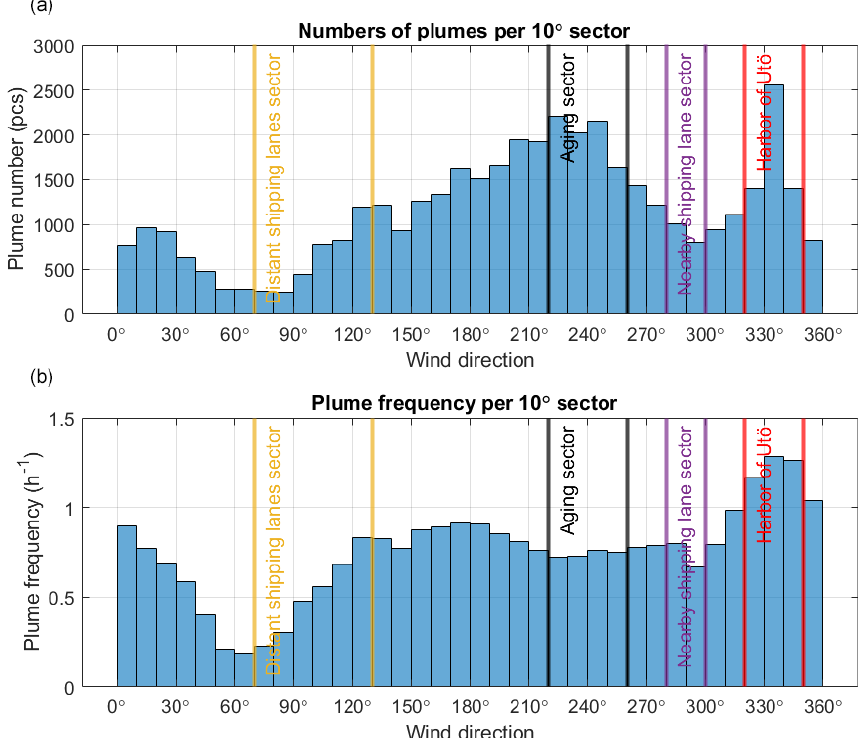
Figure 4. (a) Number of valid plumes and (b) the frequencies of the plumes per hour from different wind directions during valid time periods. The distant shipping lanes sector, aging sector, nearby shipping lane sector, and harbor of Utö are marked using pairs of vertical